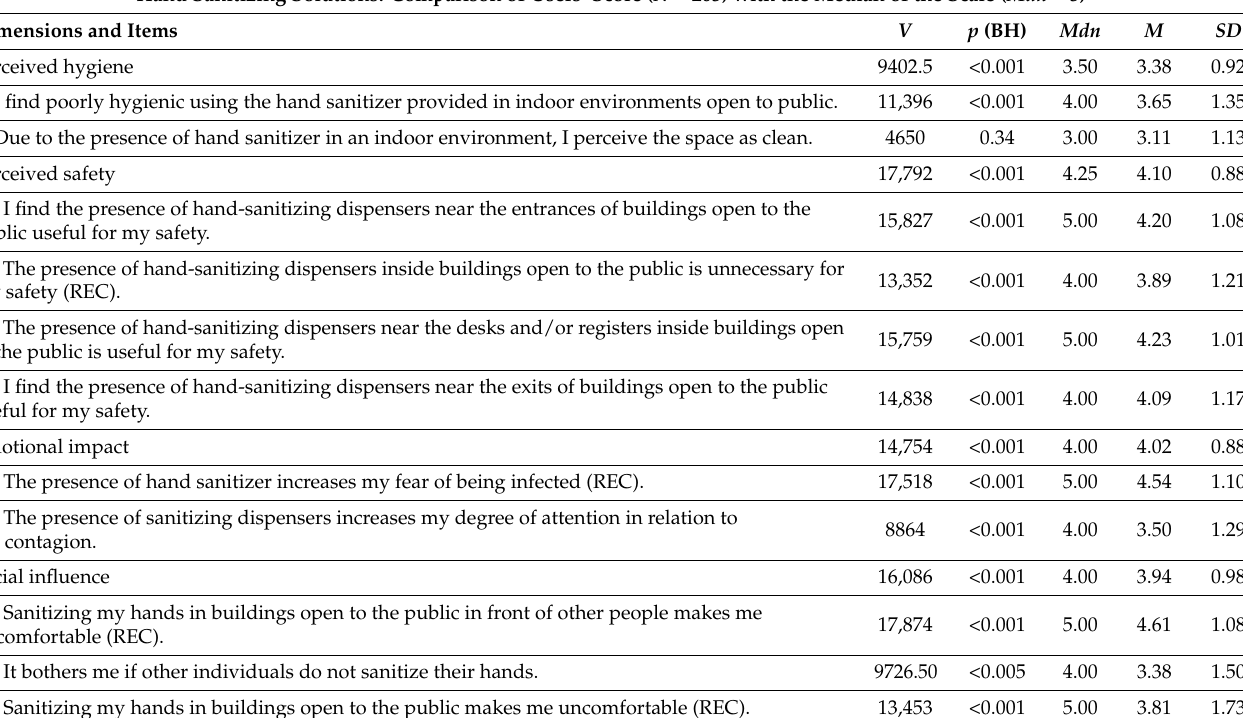
Table A1. Table illustrating the values of Wilcoxon test comparing the scores that participants assigned to each dimension with the median value of the scale (V, p (BH), median ( Mdn ), means ( M ), and standard deviations ( SD )) reported for the hand sanitizing solutions. Own processing.